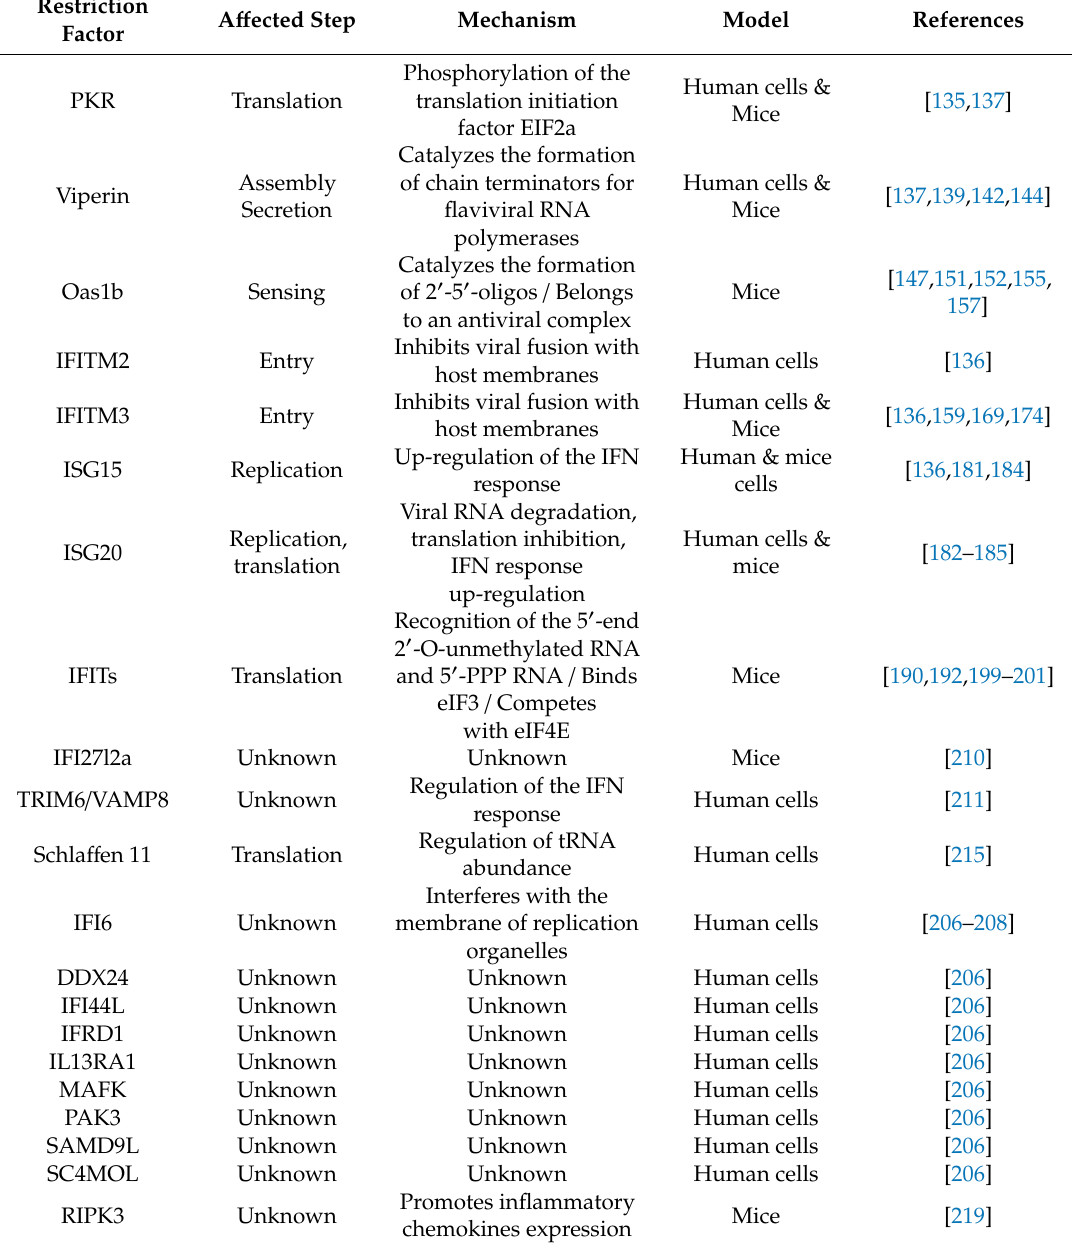
Table 1. WNV restriction factors in mammalian cells: a ff ected step of the viral replication cycle, mechanism, and